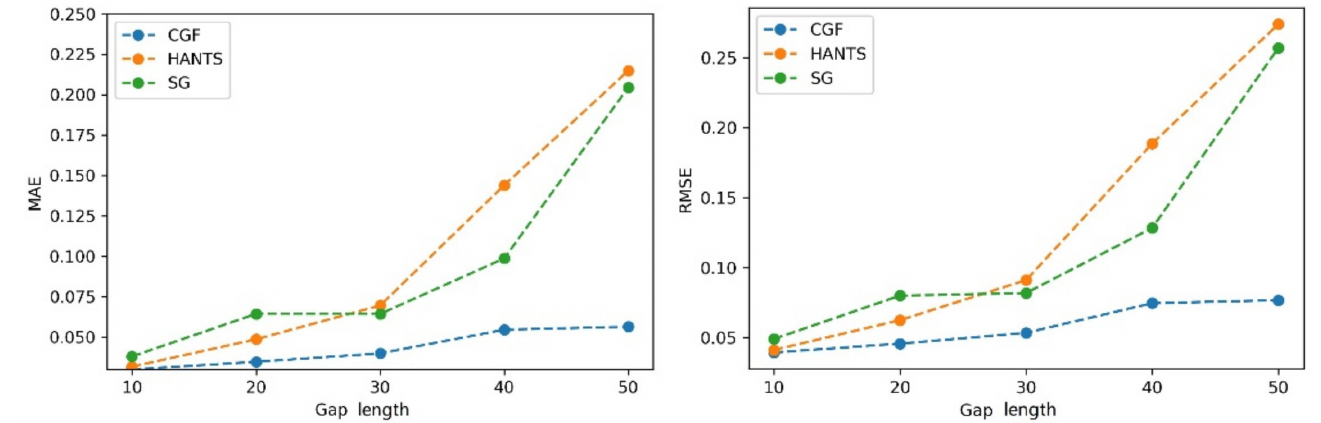
Figure 8. The performance of the NDVI reconstruction model with different consecutive gap